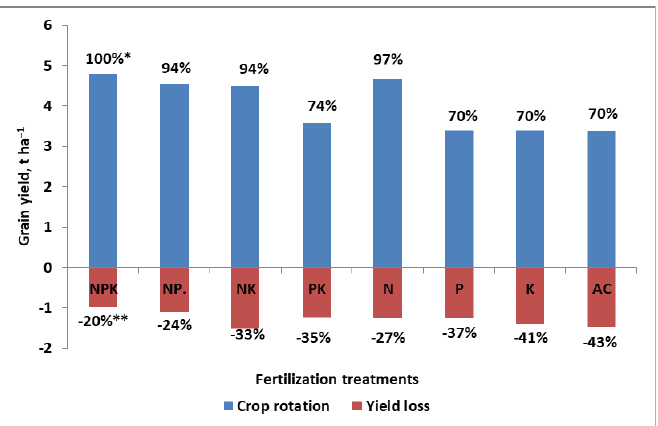
Figure 2. Effect of fertilization variants on yield of winter rye grown in 7-course crop rotation and monoculture (based on [65]). Legend: * Yield on the NPK variant = 100%; ** yield reduction—yield gap due to crop monoculture.